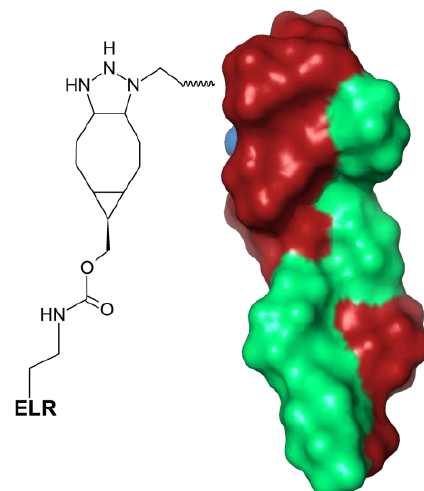
Figure 13. Schematic representation of the GL13K peptide hybridized with cyclooctyne-modified elastin-like recombinamer (ELR) (spacer). GL13K secondary structure was calculated with I-Tasser. In blue: hydrophilic amino acids; in red: hydrophobic amino acids; in green: positively charged amino acids.